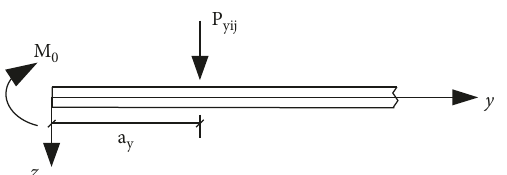
Figure 7: Elastic foundation beam model of grille